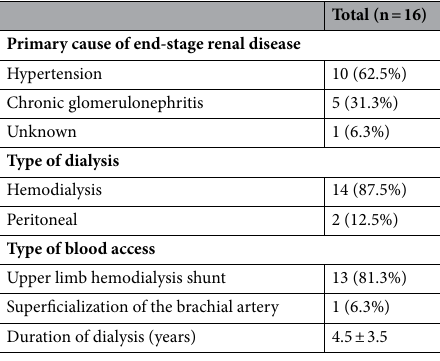
Table 2. Characteristics of the renal disease. Values for categorial variables are given as count (percentage); values for continuous variables are given as mean ± standard deviation.